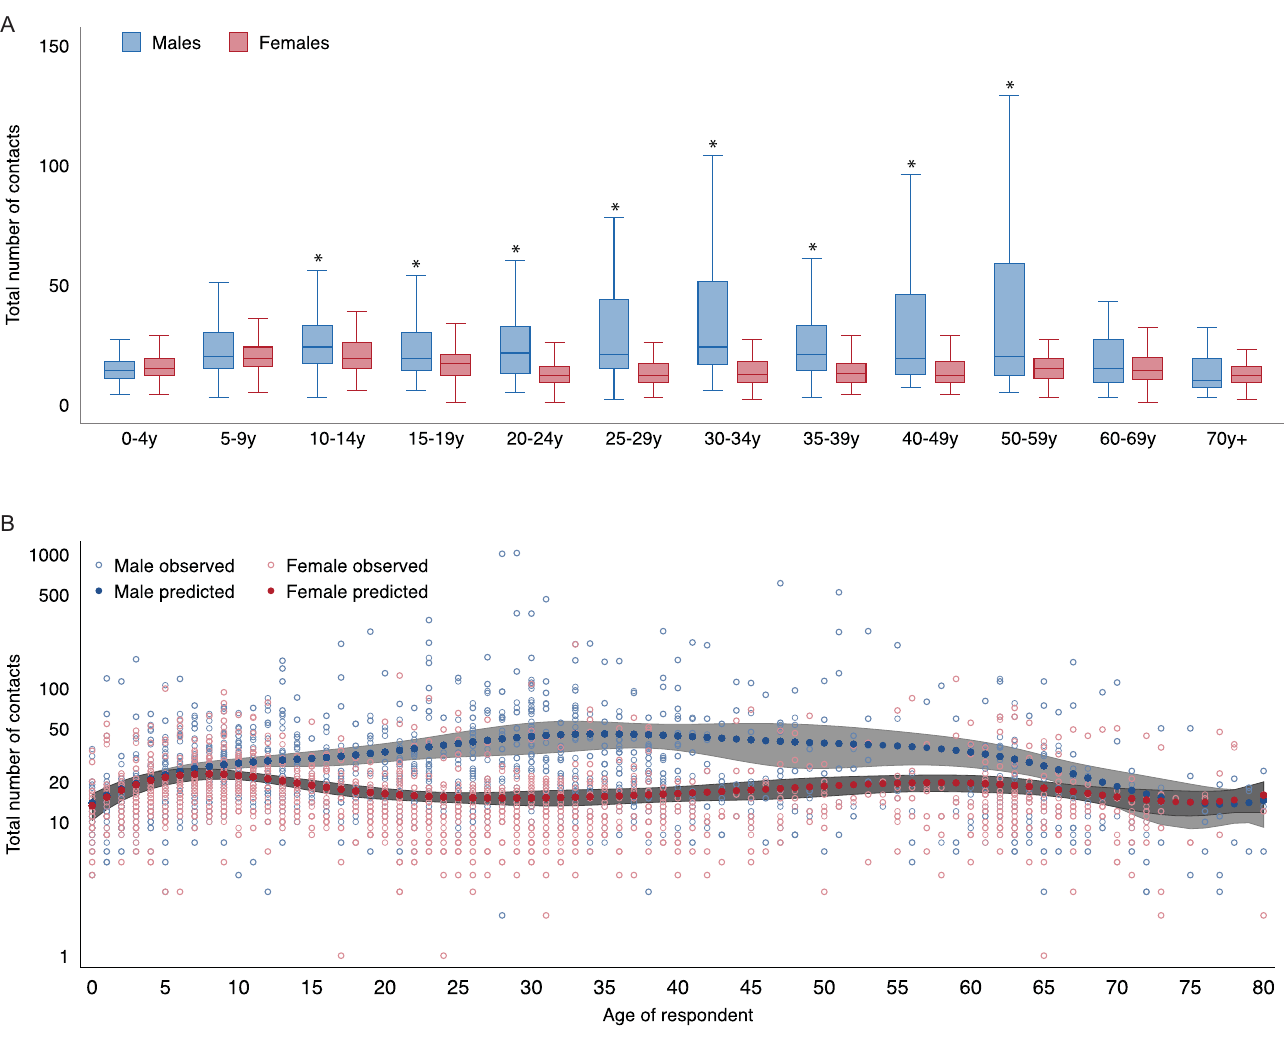
PLOS ONE | https://doi.org/10.1371/journal.pone.0209039 December21,